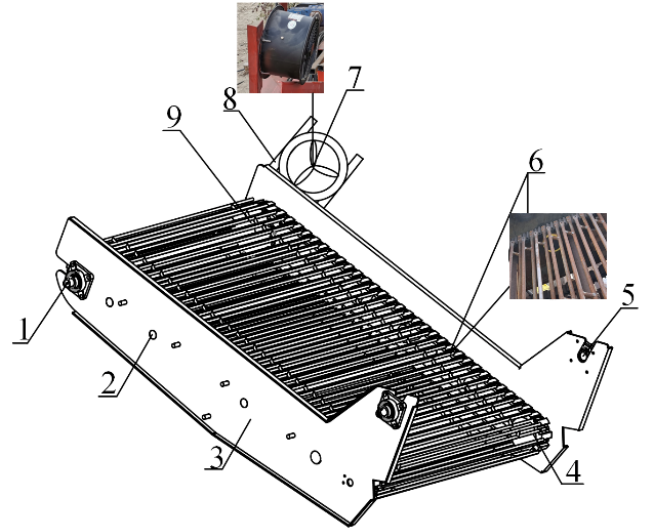
Figure 6. Schematic diagram of conveying and separating device. 1. Conveying drive shaft. 2. Supporting wheel. 3. Conveying side plate. 4. Conveying rod set. 5. Pickup active bearing seat. 6. Conveying combination rod. 7. Axial flow fan. 8. Fan base. 9. Plum blossom wheel.